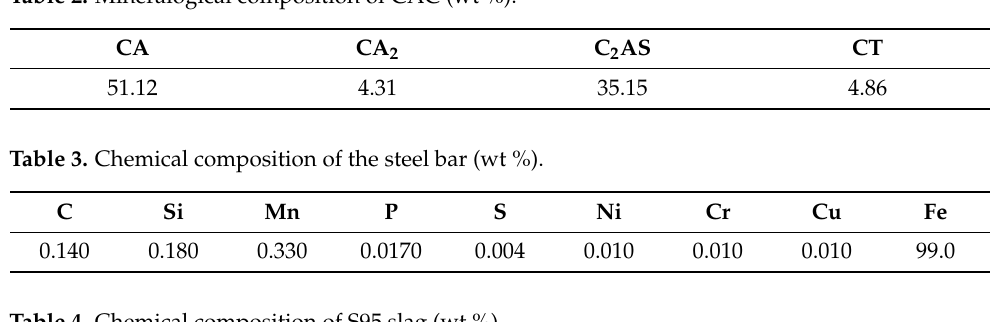
Table 4. Chemical composition of S95 slag (wt